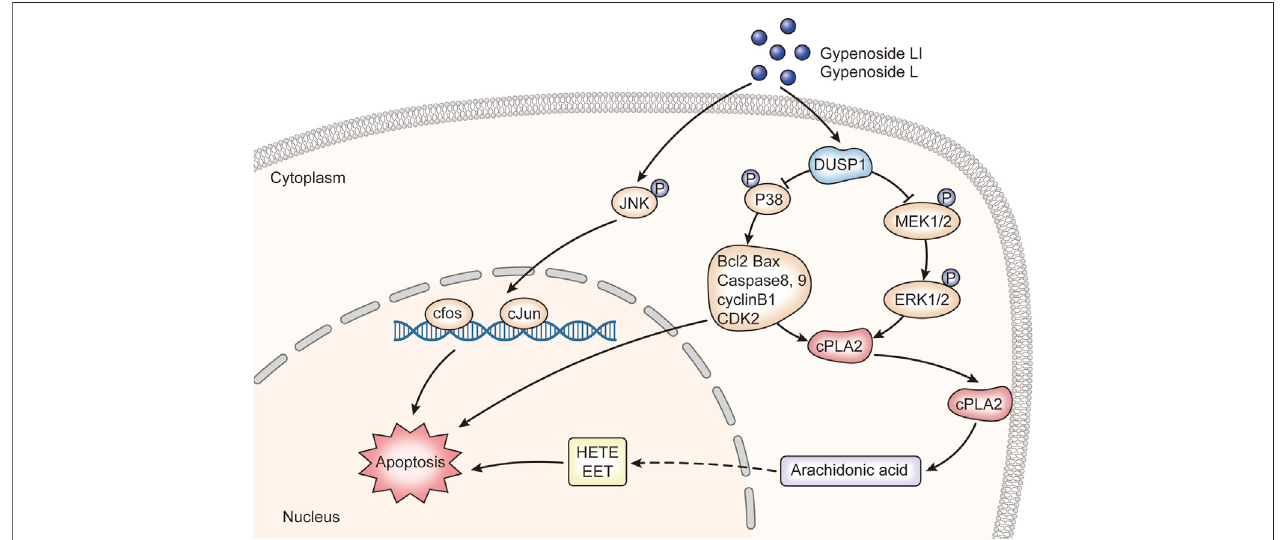
FIGURE 7 | The molecular mechanism of gypenoside L and gypenoside LI inducing apoptosis in renal cell carcinoma.